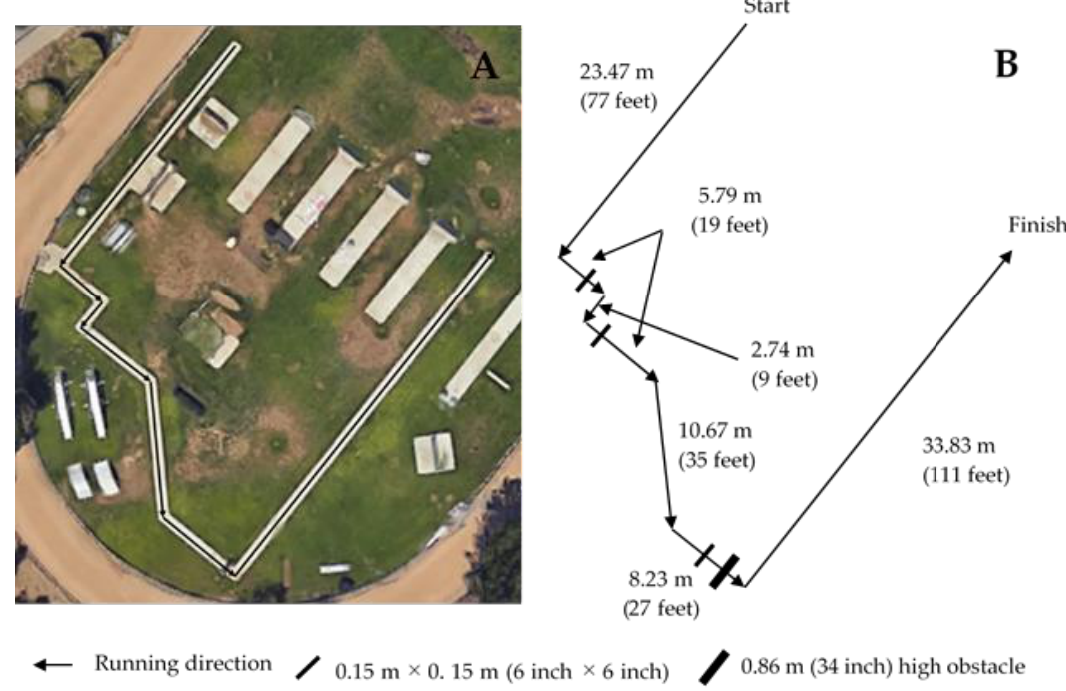
Figure 1. The 99-yard obstacle course. ( A ) Aerial map of the course. ( B ) Dimensions and running